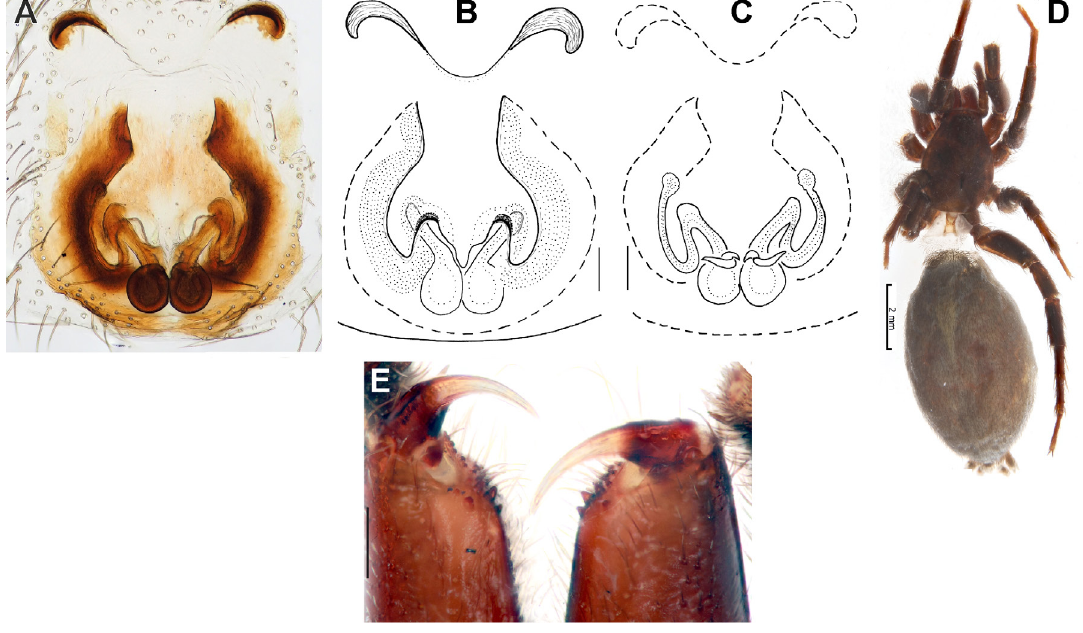
Fig. 27. Zelotes hyrcanus sp. nov., holotype, ♀ (MHNG). A, C . Epigyne, ventral view. B . Epigyne, dorsal view. D . Habitus, dorsal view. E . Chelicerae, posterior view. Scale bars: B–C = 0.1 mm; D = 2 mm; E = 0.2